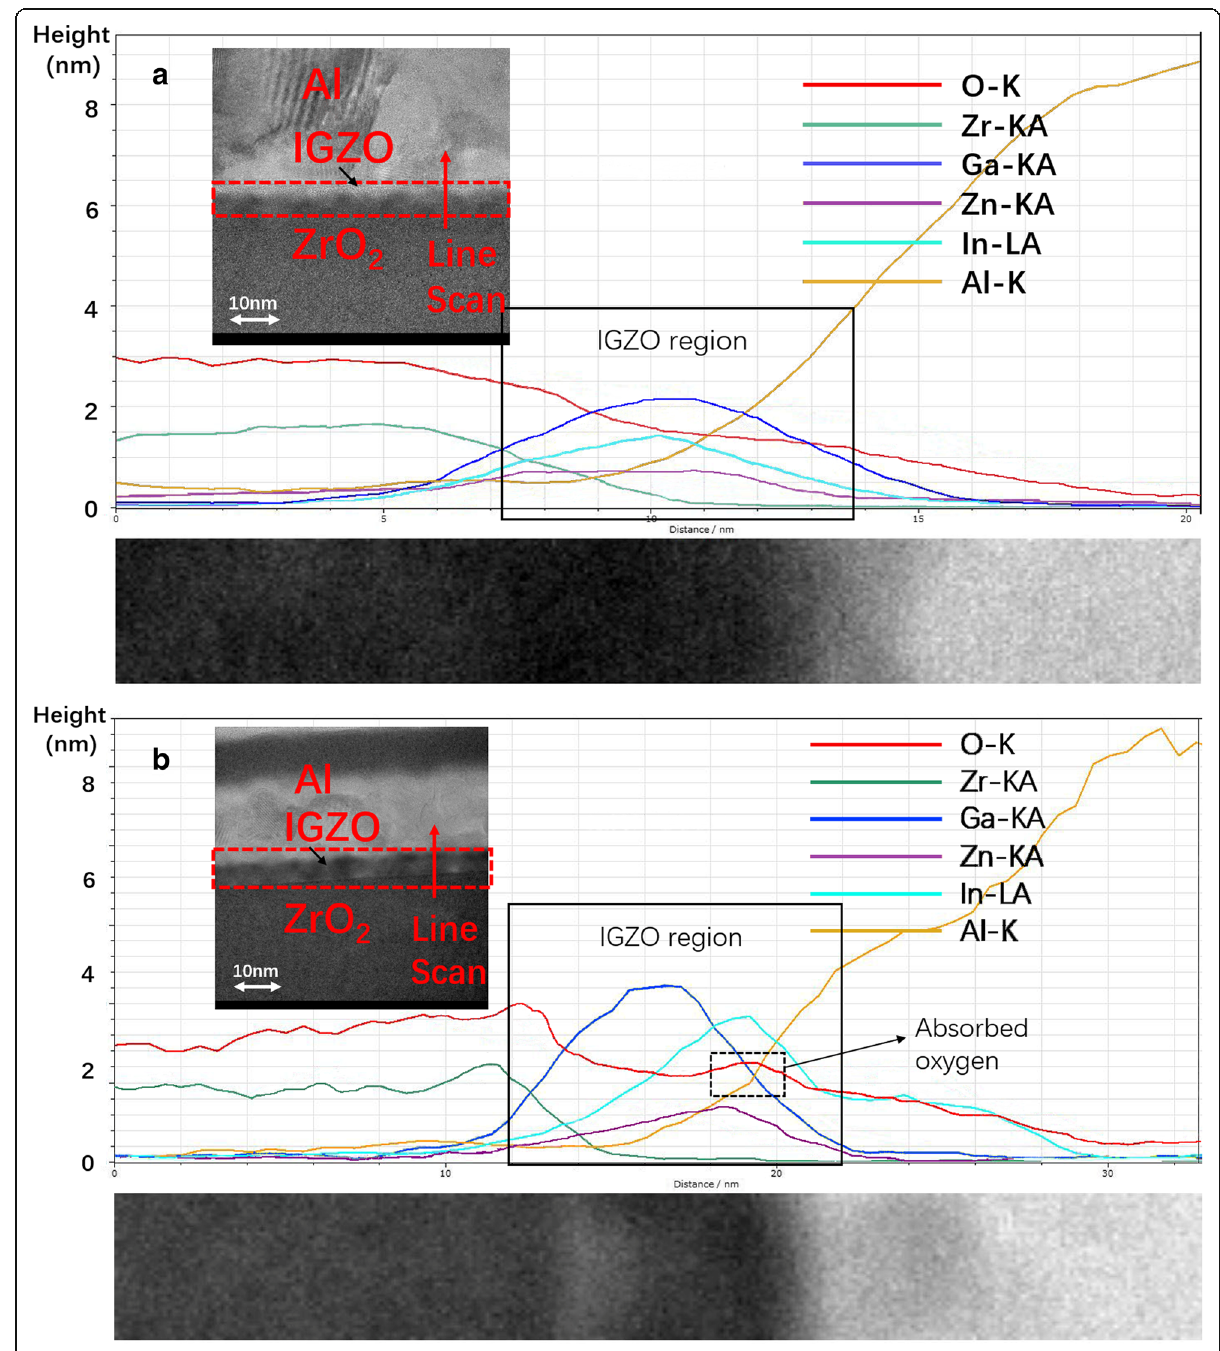
Fig. 6 a TEM image and EDS line scanning of SC-ZrO 2 IGZO TFT. b TEM image and EDS line scanning of DP2-ZrO 2 IGZO